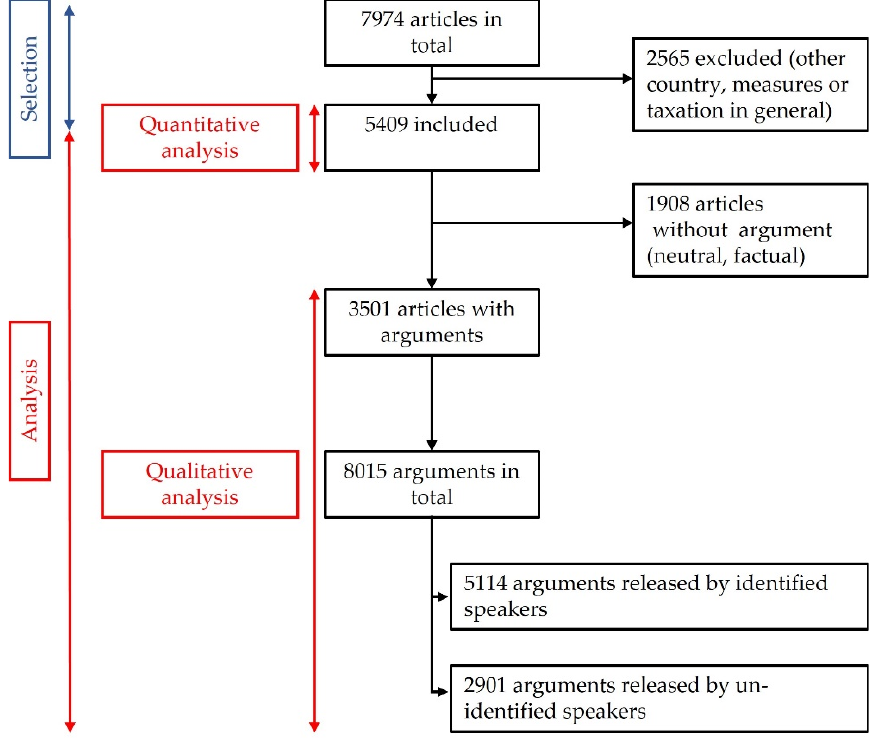
Figure 1. Flowchart for the article selection and argument analysis process .